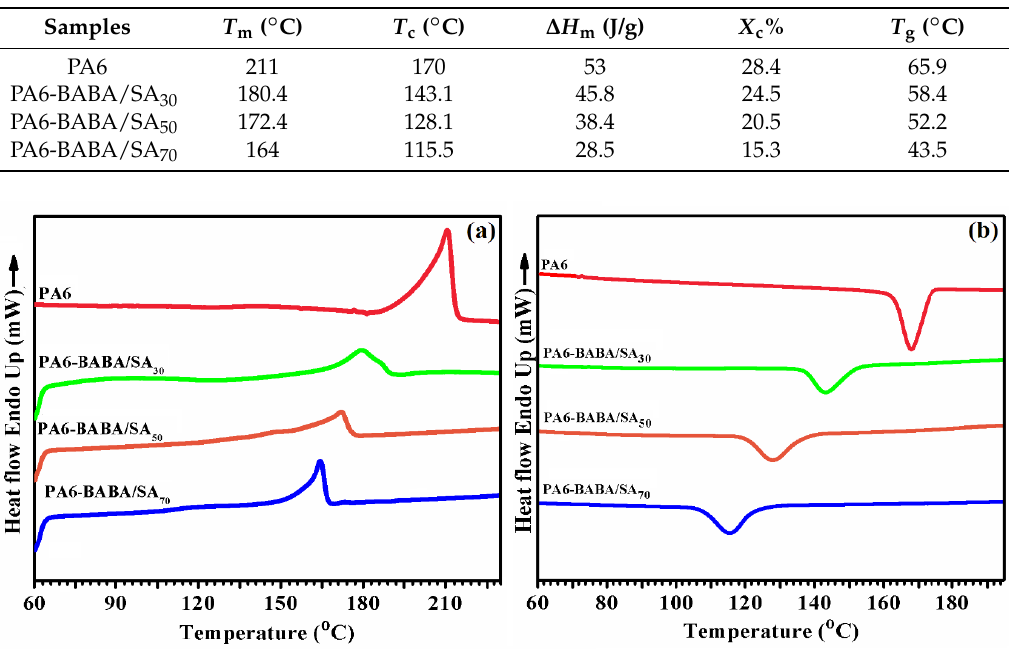
Figure 4. Differential scanning calorimetry (DSC) analyses of virgin PA6 and PA6-BABA/SA copolyamides: ( a ) heating curves (10 °C/min) and ( b ) cooling curves (10 °C/min). Table 2. Thermal properties and calculated degrees of crystallization of neat PA6 and PA6-BABA/SA copolyamides.